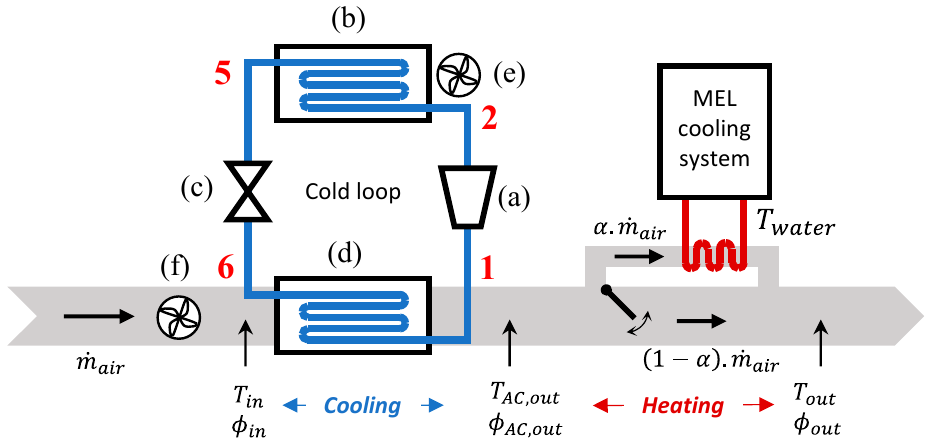
Figure 2. Schematic diagram of the HVAC system.